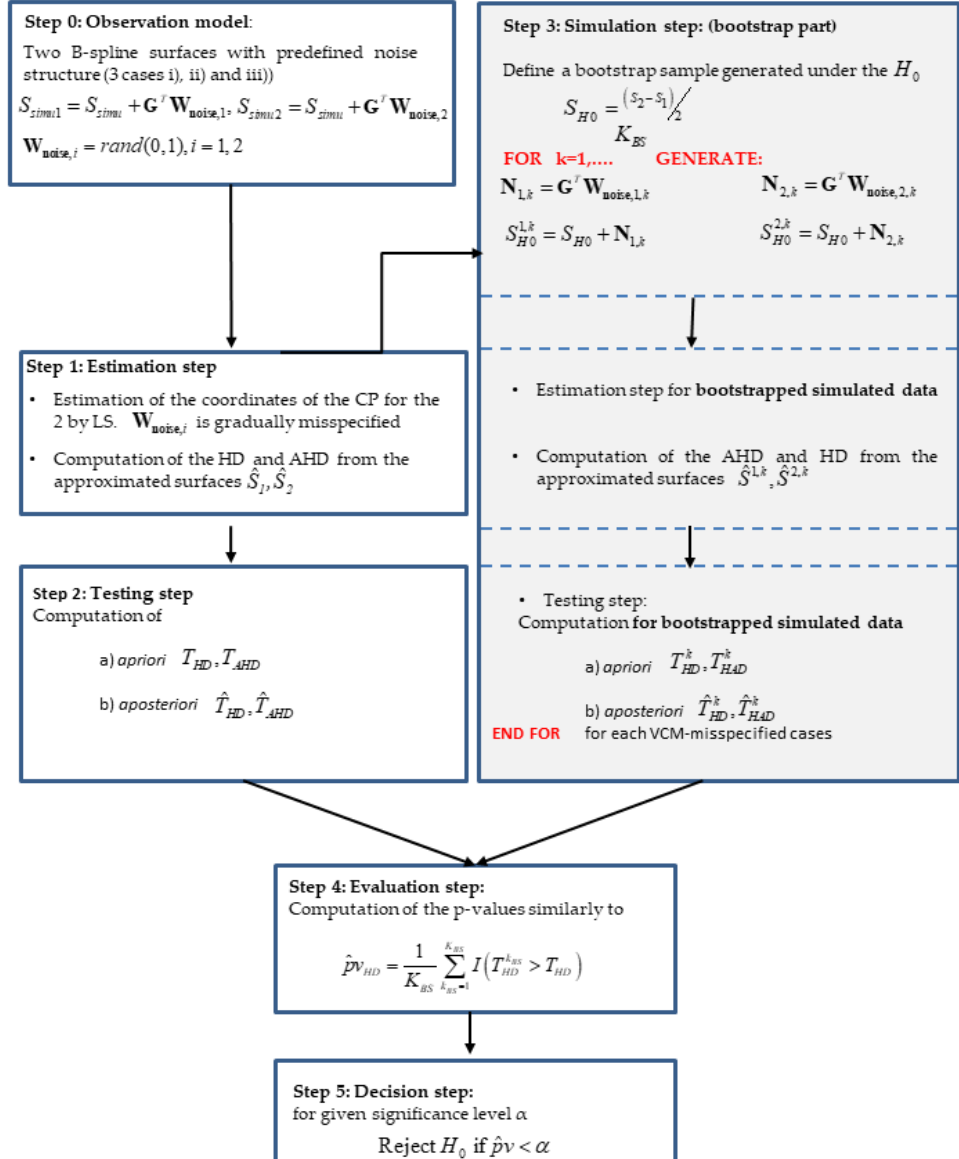
Figure A2. Flowchart explaining the bootstrap Figure B1 Flowchart explaining the bootstrap simulation.